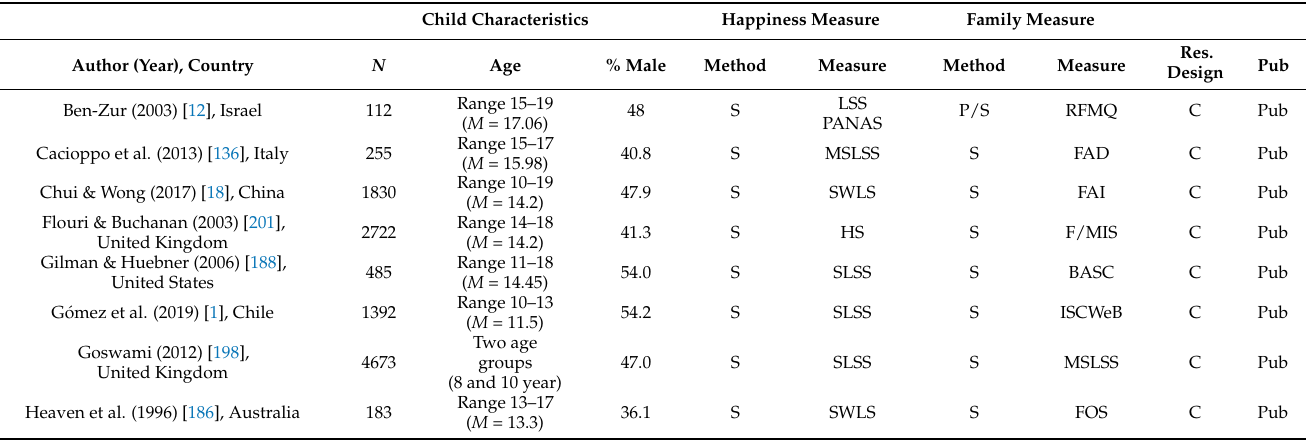
Table 2. Sample Characteristics and Methods of Assessment of the Reviewed Studies Investigating Global Family Functioning, Environment Variables, and Happiness ( n =